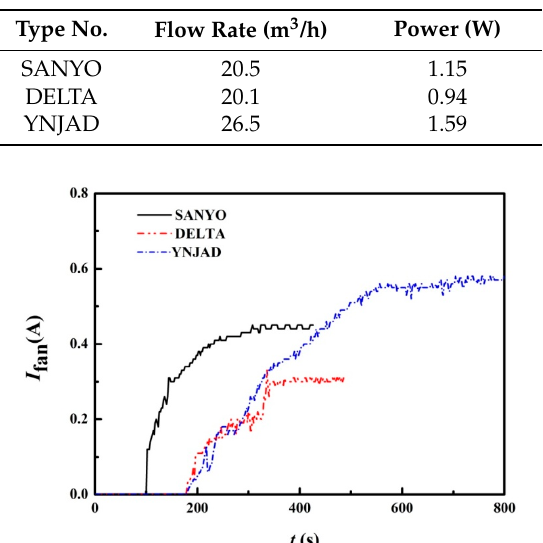
Figure 9. Influence of cooling fan selection on STEG output power performance (HS1 heat sink, Cod1 heat conducting plate and Cof1 configuration).